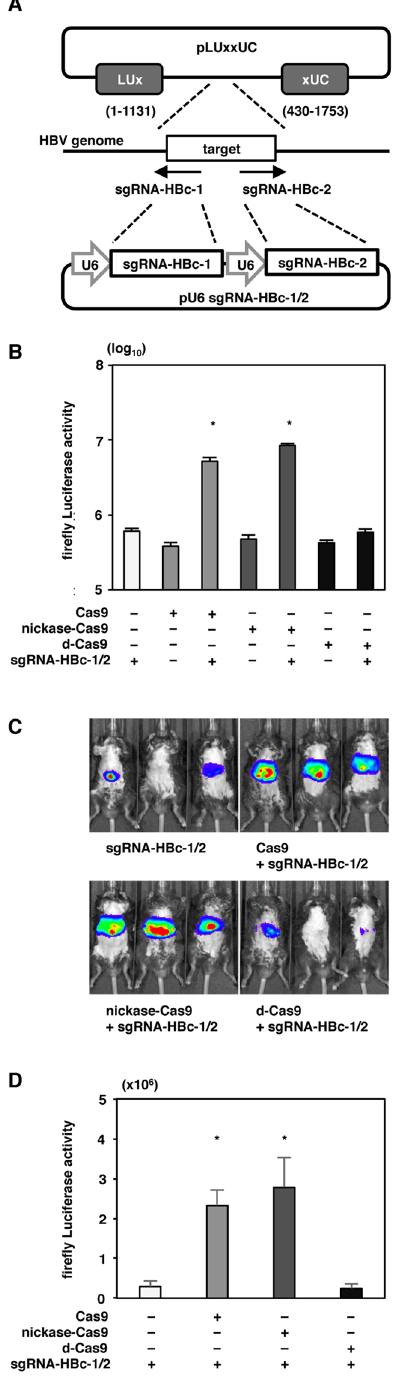
Figure 6. The effect of nickase-Cas9 with the pair of sgRNAs in vivo . ( A ) Schematic of the split LUxxUC plasmid inserted into the target HBc sequence and pU6-sgRNA-HBc-1/2 targeting the HBc sequence. A recombination of firefly luciferase is induced by DSBs on the inserted targeted sequence. ( B ) Cas9, nicakse-Cas9 and d-Cas9 with a pair of sgRNA-HBc-1/2-expressing plasmids were transfected with split LUxxUC plasmid into 293T cells. The firefly luciferase activity was determined at 24 hr post -transduction. ( C , D ) Cas9 and nickase-Cas9 plus the pair of sgRNA-HBc-1/2 or d-Cas9 plus the pair of sgRNA-HBc-1/2 with split LUxxUC- expressing plasmids were delivered into the livers of C57BL/6j mice via hydrodynamic injection (n = 3 mice per group). Luciferase activity was detected at 2 days post injection. The luciferase intensity was measured by an IVIS system. * p < 0.01 vs. the results for control